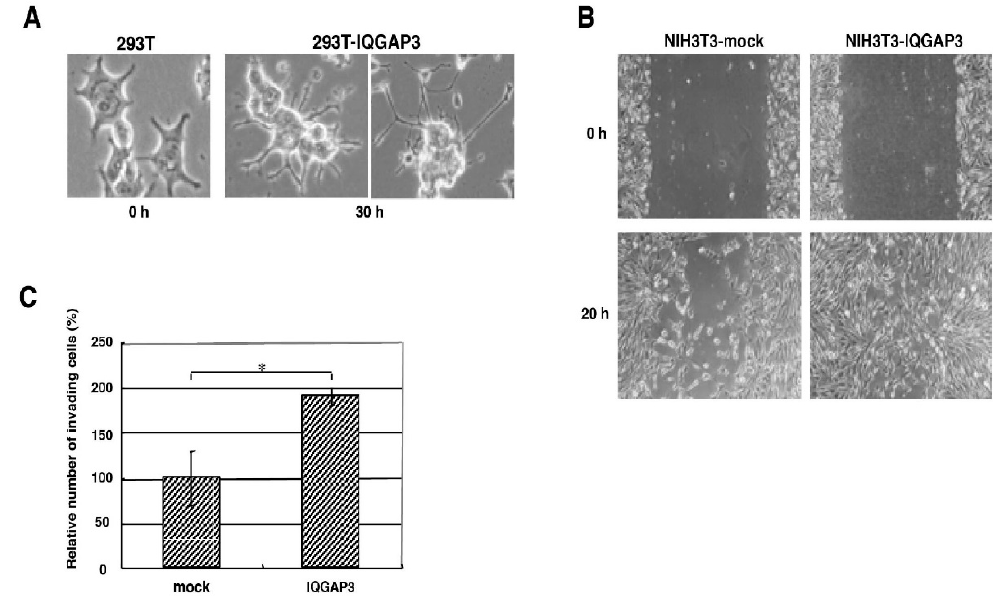
Figure 3. Effect of IQGAP3 on cellular morphology, motility, and invasion. ( A ) Morphological change of 293T cells by exogenous IQGAP3 expression. ( B ) Representative pictures of the wound-healing assay using NIH3T3 cells expressing IQGAP3 (NIH3T3-IQGAP3) and control (NIH3T3-mock) cells. ( C ) Effect of IQGAP3 on cell invasion by Matrigel assay. The relative number of invading NIH3T3-IQGAP3 cells was compared with control (NIH3T3-mock) cells (* p < 0.01; two-tailed Student’s t -test).